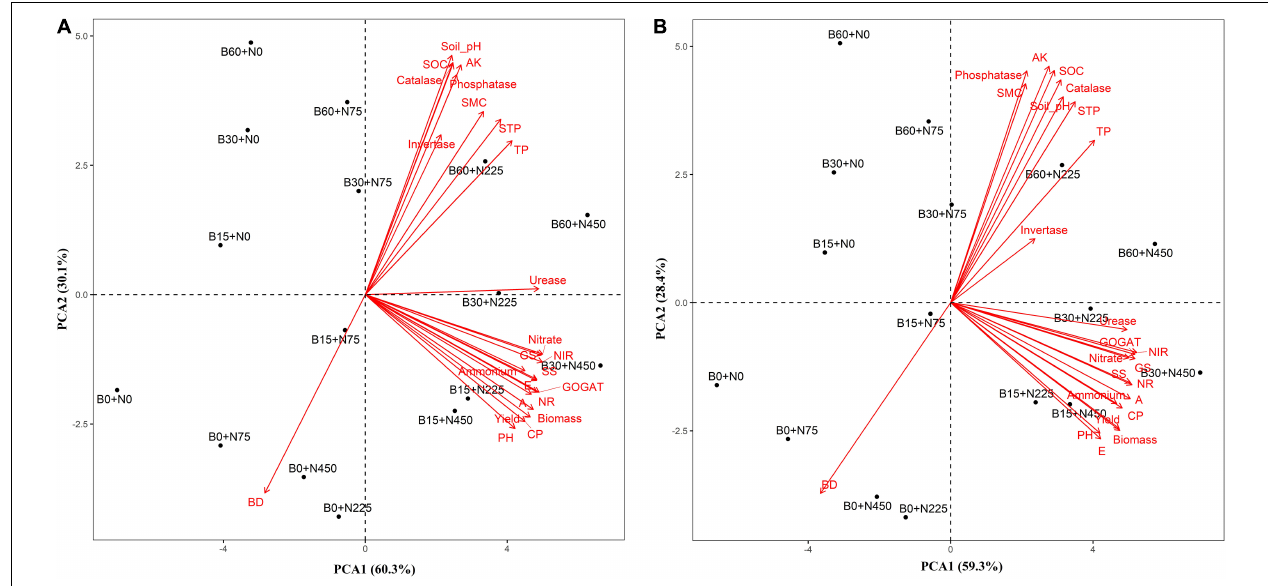
FIGURE 7 | Principal component analysis of soil physiochemical properties, growth and yield traits in 2019–2020 (A) and 2020–2021 (B) . SOC: soil organic carbon, TP: total phosphorus, AK: available potassium, STP: soil total porosity, SMC: soil moisture content, BD: bulk density, NR: nitrate reductase, NIR: nitrite reductase, GS: glutamate synthase, GOGAT: glutamine synthetase, A: photosynthesis, E: transpiration, SS: soluble sugar, CP: crude protein, PH: plant